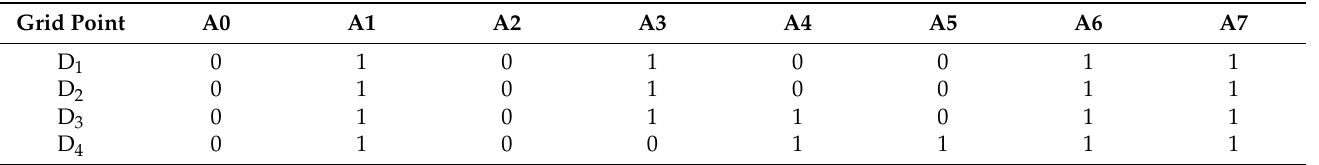
Table 1. Example of values for locating the estimated point proximity area containing four grid points.